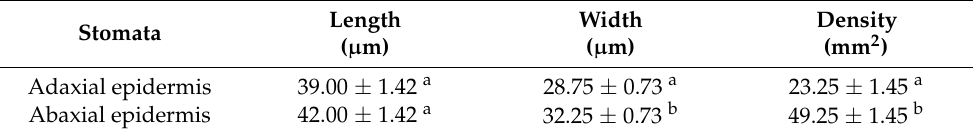
Table 1. Nicotiana tabacum var. Virginia. Length, width, and stomatal density in leaf epidermis. Length Width Density Stomata ( µ m) ( µ m) (mm 2 ) Adaxial epidermis 39.00 ± 1.42 a 28.75 ± 0.73 a 23.25 ± 1.45 a Abaxial epidermis 42.00 ± 1.42 a 32.25 ± 0.73 b 49.25 ± 1.45 b